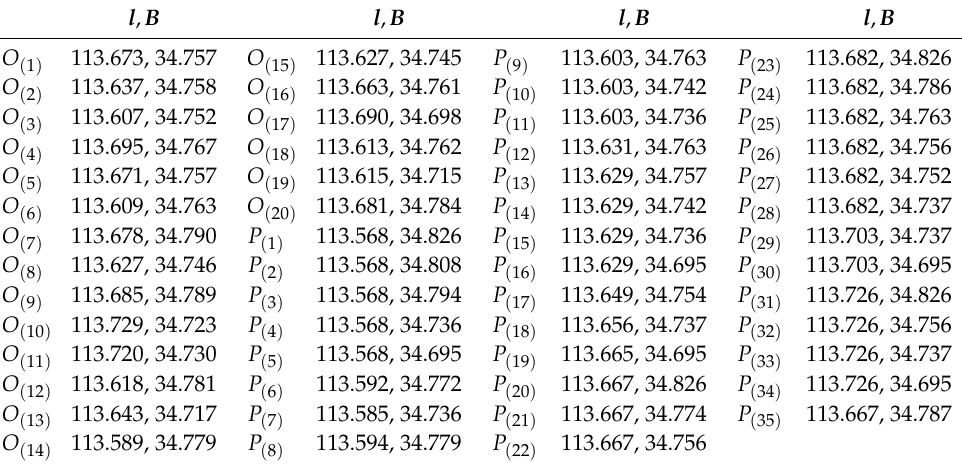
Figure 6. The distribution of tourist attraction cellular core set and road intersection point set and their overlying map. ( a , b ) show the distribution of tourist attractions and road intersections. ( c ) shows all the points. The latitude and longitude website GPSspg is used to obtain the coordinates of the tourist attractions and location points, shown in Table 1. Table 1. The coordinate data of the tourist attraction cellular unit x ( k ) ∼ O ( k ) and location points P ( v )